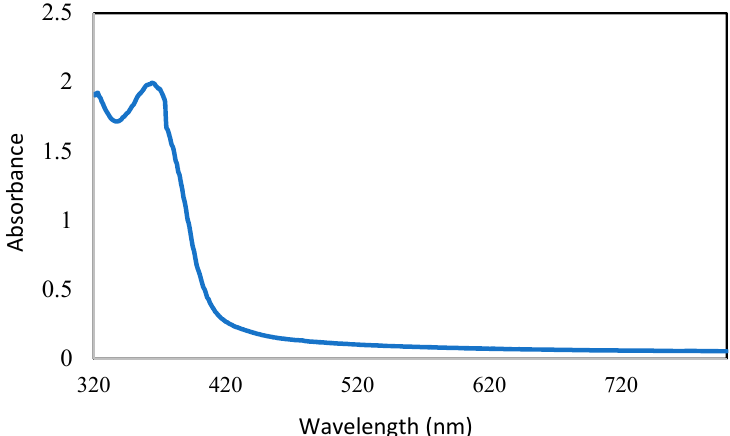
Figure 1. Visible spectrum of pomegranate peel extract. Generally, the visible spectrum of flavonoids shows peaks in the 300–400 nm region. These peaks are associated with the cinnamoyl system (Figure 2) [19]. The absorbance shifts towards higher wavelengths by increasing conjugation [20]. Figure 2. Structural base of the cinnamoyl system. 3.3. Effect of the Dye Concentration Colorimetric data were considered to evaluate the influence of dye concentration during the dyeing of polyamide fabrics. Different dye concentrations (2%, 4%, 5%, 6% and 7%) were used. Colorimetric data are shown in Table 2. Table 2. Shades and colorimetric data obtained for the dyed polyamide fabrics at different concen- trations. Extract (%) Shade